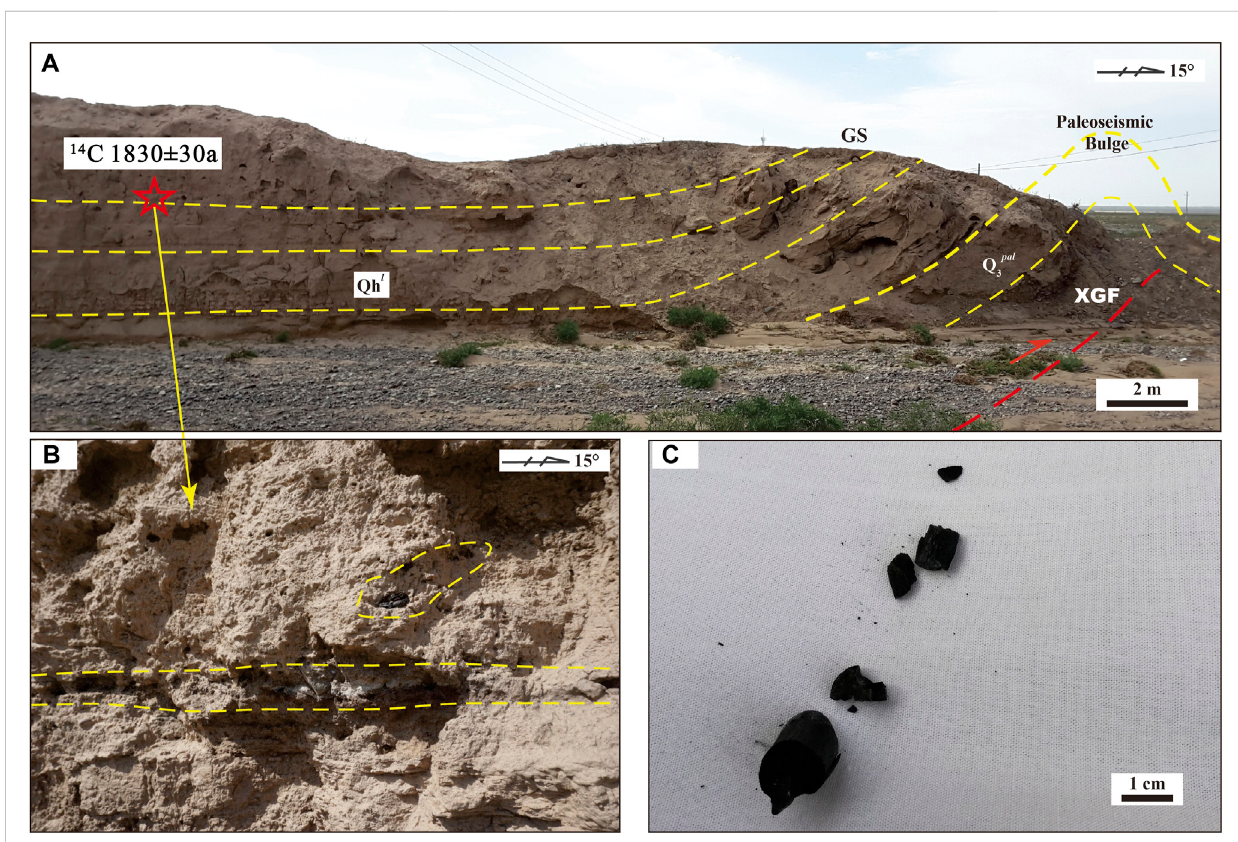
FIGURE 7 Structural analysis of the Dagengzi Fault (DGF). (A) Cross-sectional view of the blind DGF, showing the growth strata (GS), broken anticline, and sample locality of the plant charcoal. Qh l — Holocene lacustrine sediments. (B) Occurrence of the plant charcoal layer in the Holocene lacustrine argillaceous siltstone formation. (C) Charcoal sample in detail. See location in Figure